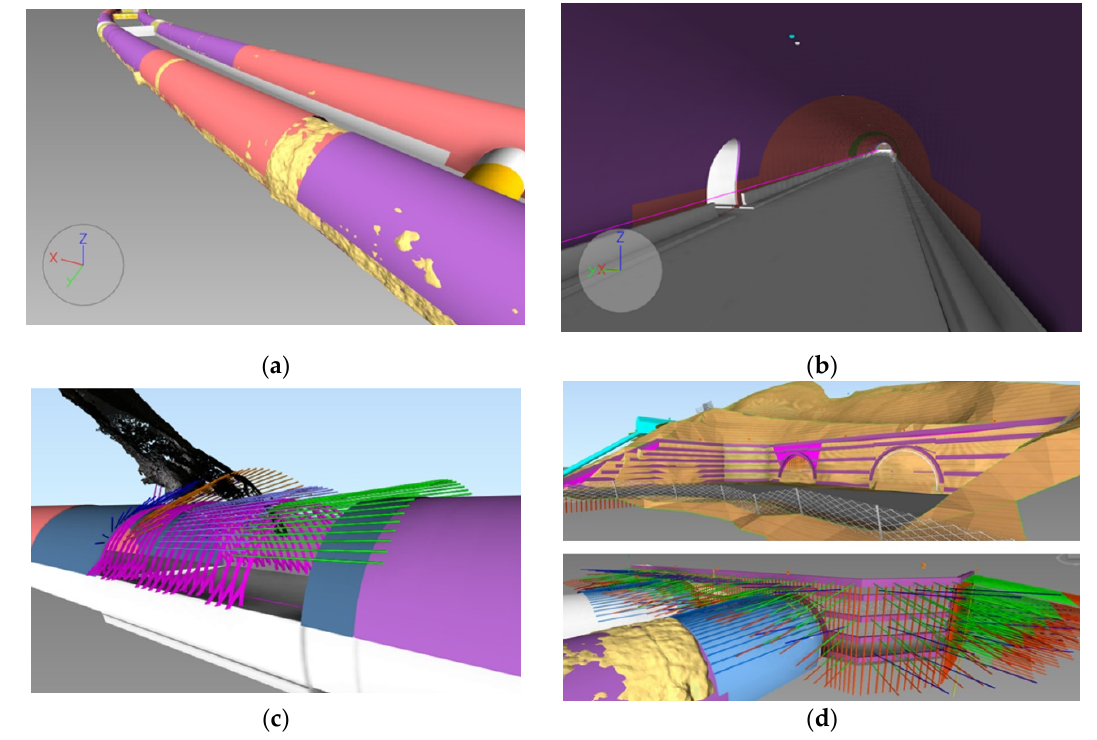
Figure 9. Follow-up model use: ( a ) check of interference between shotcrete surface after each advance step and theoretical surface from outside the tunnel; ( b ) check of interference between shotcrete surface after each advance step and theoretical surface from inside the tunnel; ( c ) analysis of micropiles umbrella possible interferences; ( d ) analysis of anchor system in tunnel portals.